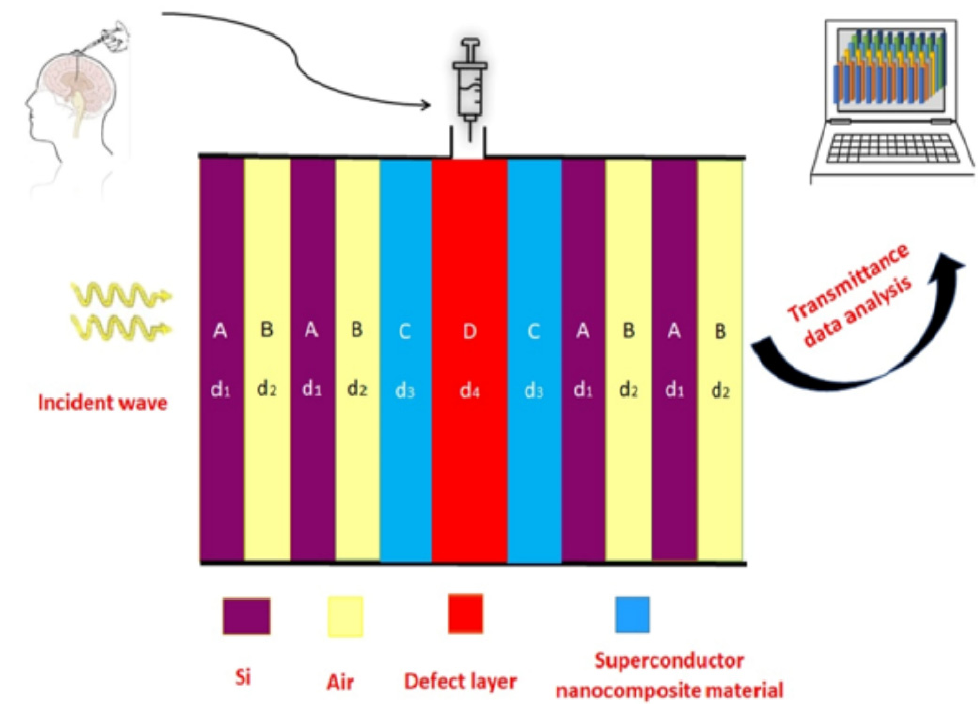
Figure 1. The schematic architecture of the proposed biosensing structure ( AB ) N CDC ( AB ) N . The fluids containing different brain tissues extracted from various parts of human brain through a long needle have been injected into the cavity region marked with red color through inlet valve mounted on top of the structure.